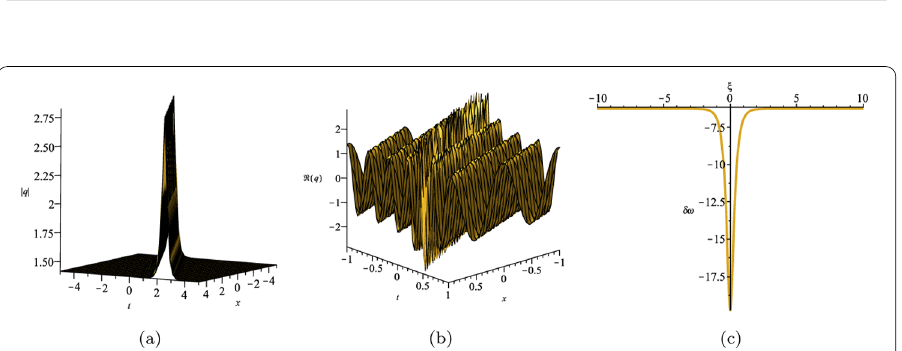
Figure 5 Chirped bright soliton solution (28) with a 1 = 4, a 2 = 1, b = 2, α = 2, λ = 6, μ = 1, ν = 1, σ = 2, Ω = 3. ( a ) Modulus. ( b ) Real part. ( c ) Corresponding chirp